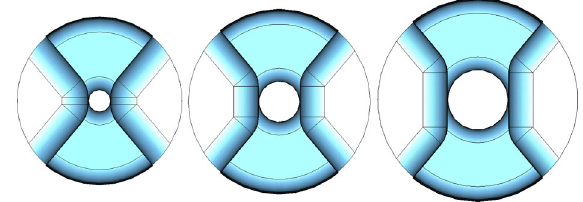
FIG. 31. RF-dipole cavity designs with trapezoidal-shaped parallel bars of varying beam aperture diameter and inner bar height for a given angle.